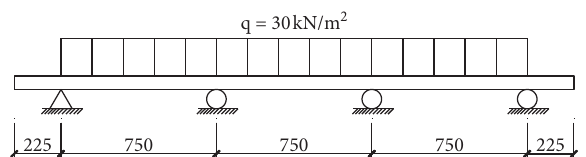
Figure 11: Loading diagram of the three continuous supported formworks.